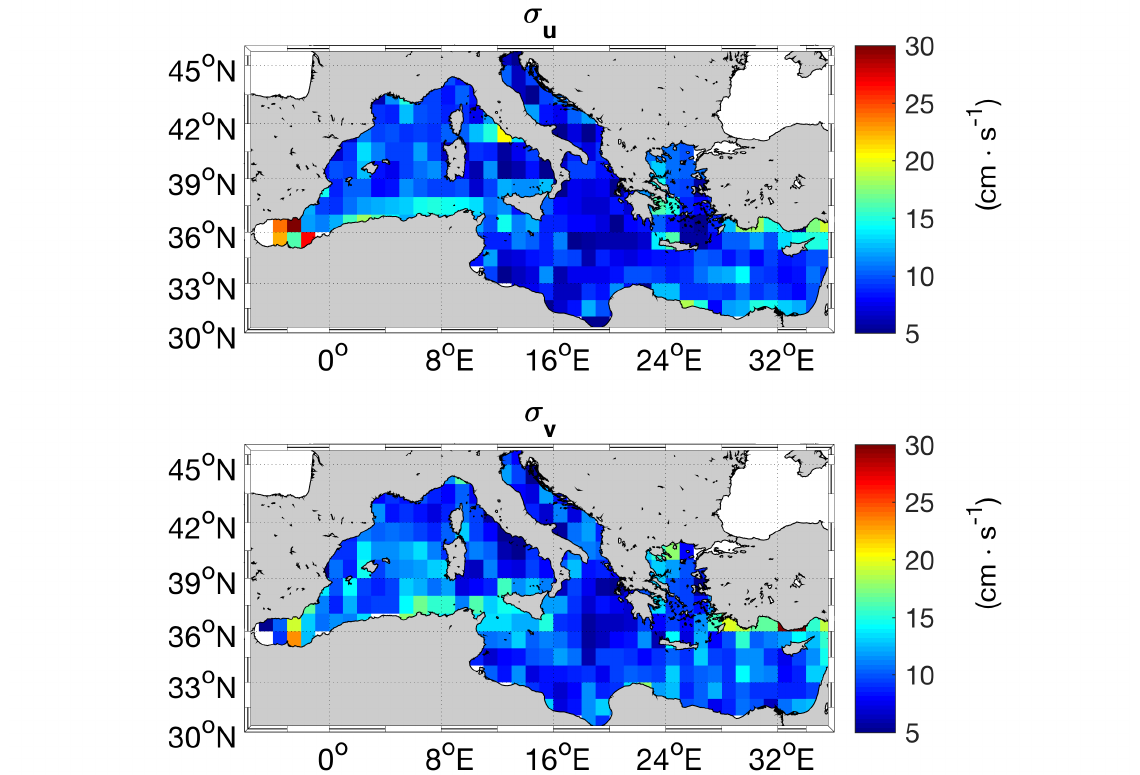
Figure 3. RMSE between the altimeter and the drifter-derived surface currents, binned on 1 ◦ × 1 ◦